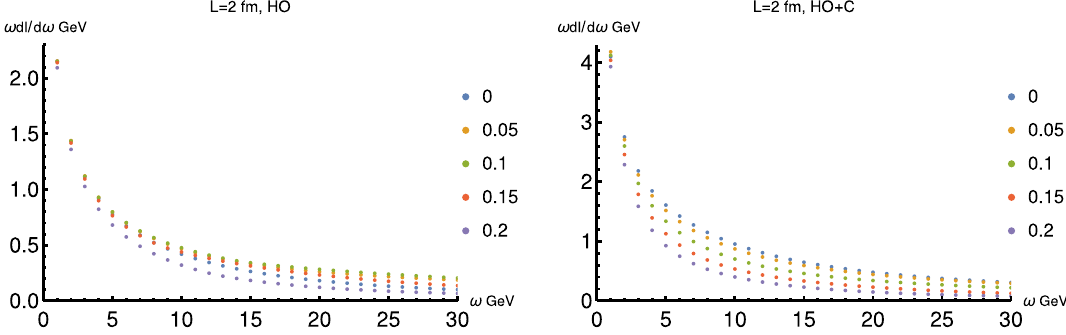
Fig. 3 The energy loss in the leading order in α s for L = 2 fm for different values of θ as a function of the radiated gluon energy ω , divided by α s C F , right-total energy loss in Moller theory, left-HO approximation. We use Eq. 20 for Q